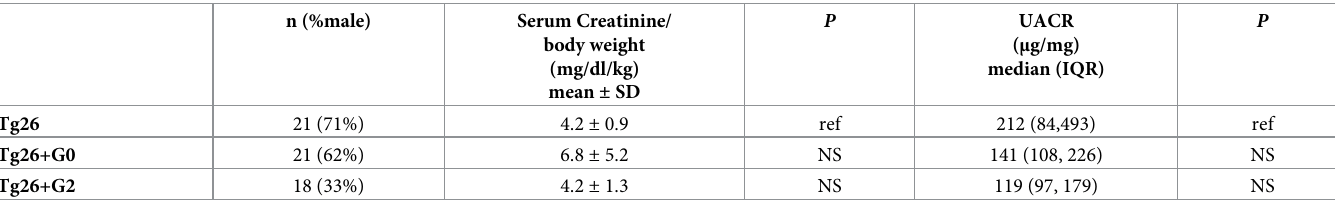
Table 2. Renal function in single and dual transgenic